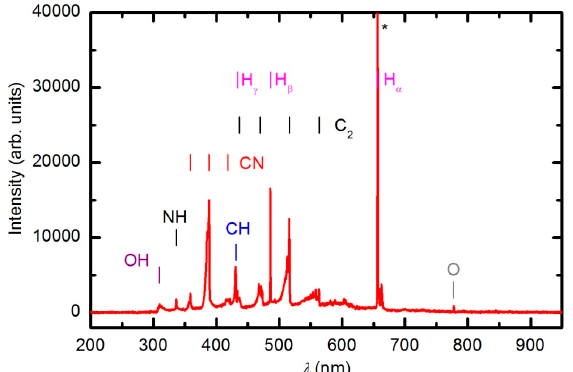
Figure 5. OES spectrum of the plasma during the etching of a PURPEG sample with oxygen plasma generated at 900 W forward RF power.